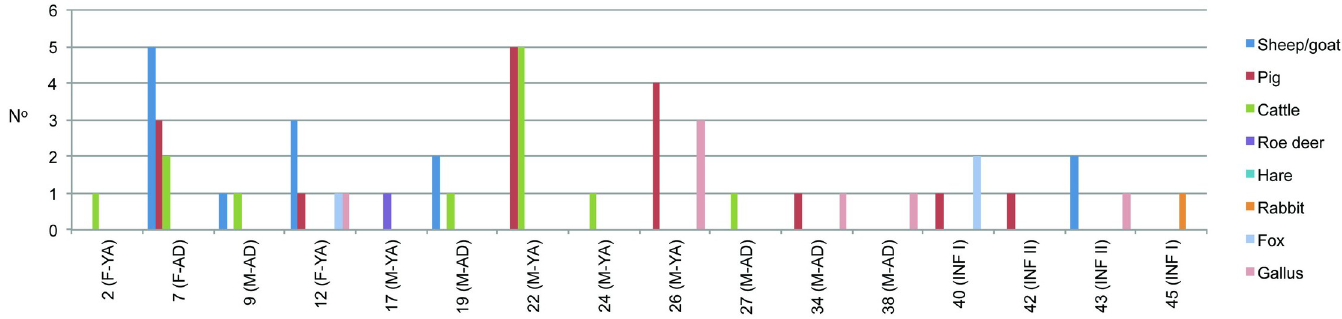
Fig 3. Number of meat offerings by species among the burials of the Vila de Madrid necropolis. (Key: F = female; M = male; AD = adult; YA = young adult; INF = infant).